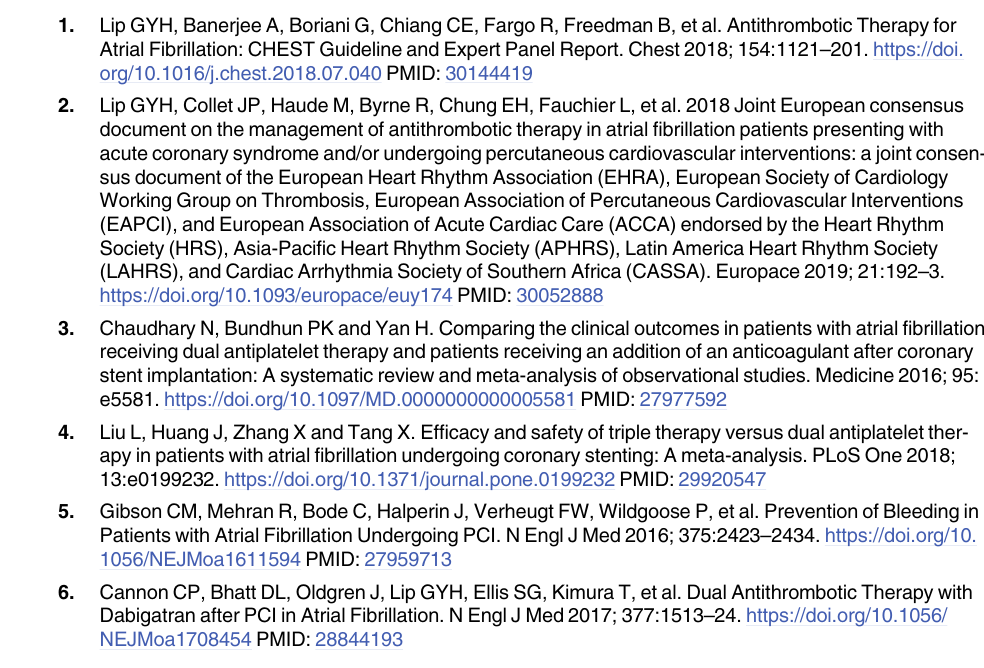
S3 Table. Clinical outcomes in dual-antiplatelet therapy group with potent P2Y